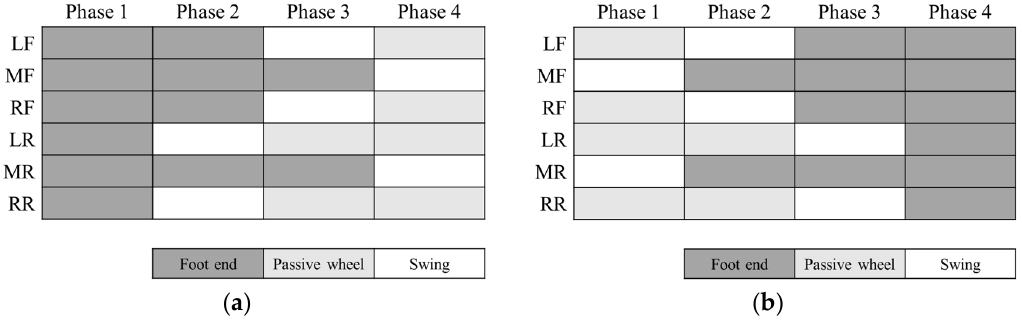
Figure 7. Leg sequence of switching process. ( a ) leg-to-wheel; ( b ) wheel-to-leg.